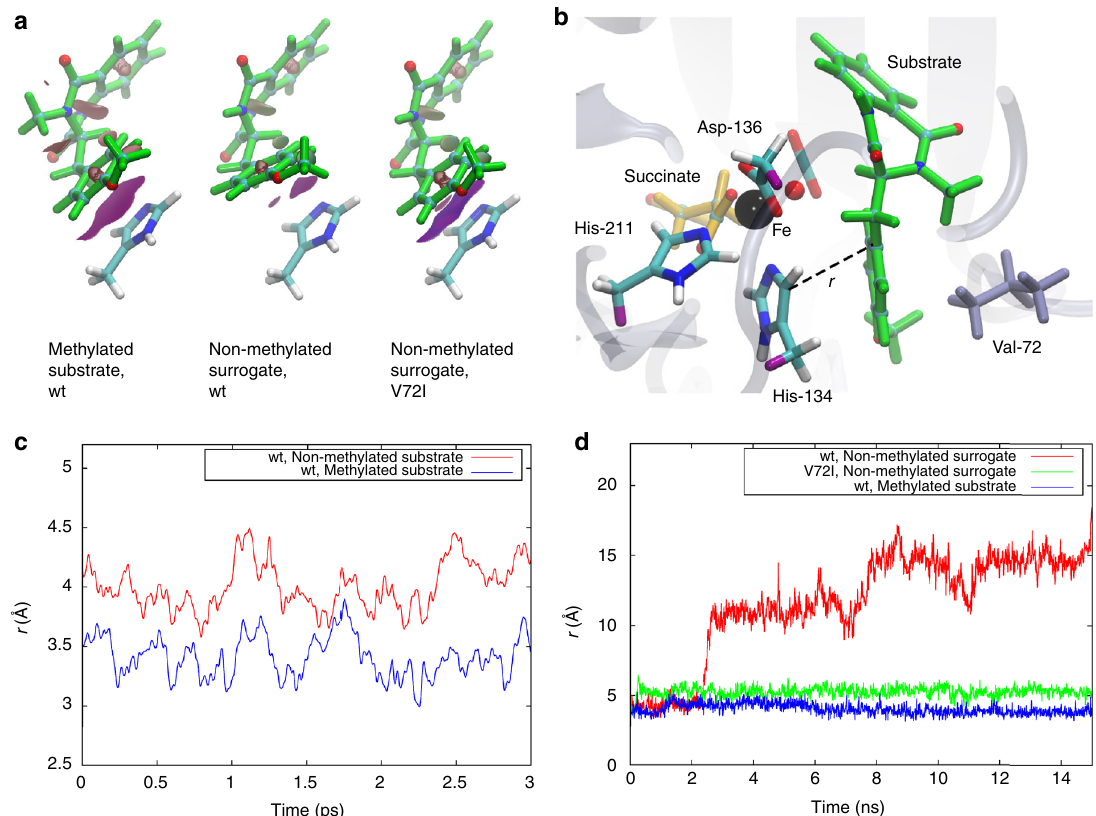
Fig. 3 Engineering AsqJ to catalyze turnover of modi fi ed surrogates. a Non-covalent interaction densities (purple surfaces) between His-134 and the methylated substrate/non-methylated surrogate for wt and V72I-mutant AsqJ prior to the fi rst PCET reaction. b Snapshot from a QM/MM MD simulation of AsqJ. The QM region is shown in colored licorice and link atoms are depicted in purple, and Val-72 is shown in gray licorice. c The stacking distance ( r ) between His-134 (CD2) and the substrate (C1 ′ ) in presence of the methylated substrate and the non-methylated surrogate after the fi rst PCET reaction. d The stacking distance ( r ) in presence of the methylated substrate and the non-methylated surrogate for wt and V72I-mutant AsqJ before the fi rst PCET reaction. The simulations were performed using both QM/MM MD simulations ( c ) and classical atomistic MD simulations ( d ) to explore